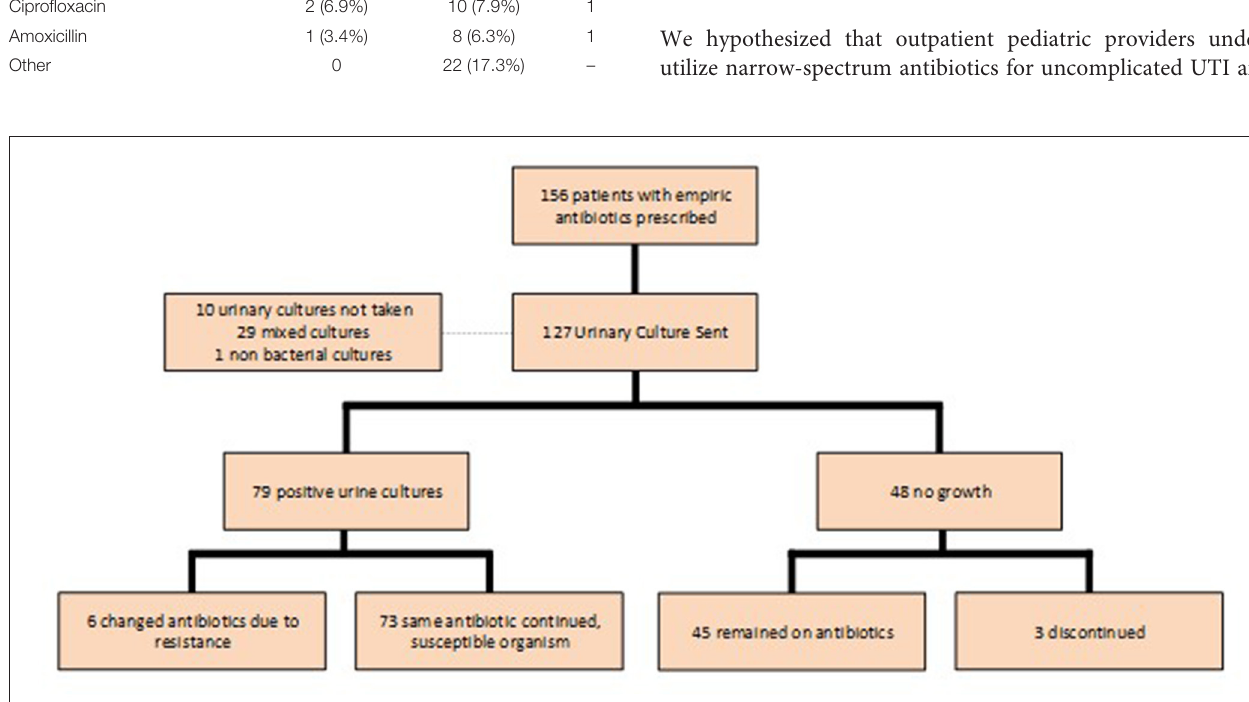
Frontiers in Pediatrics |